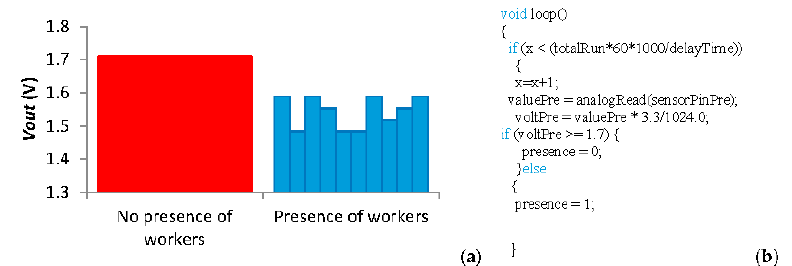
Figure 14. ( a ) Data and ( b ) code of the presence sensor.